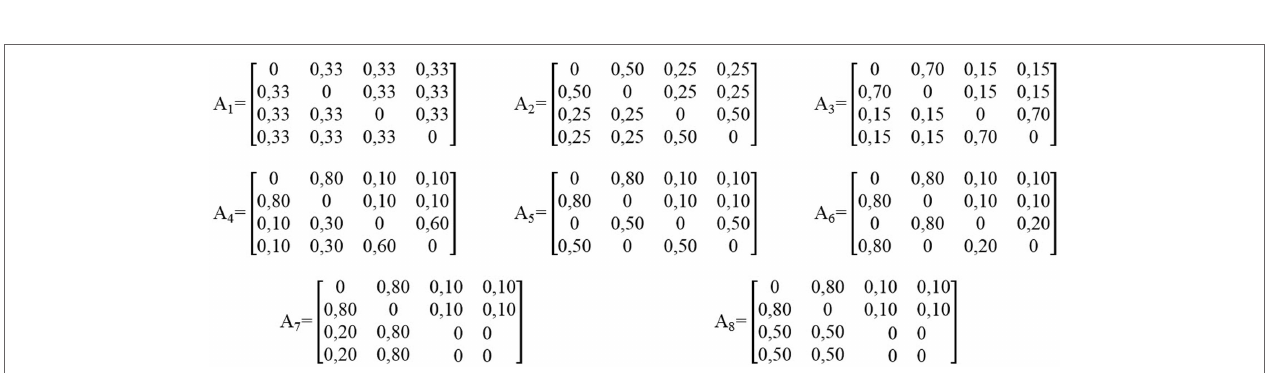
FIGURE 2 | Traffic demand